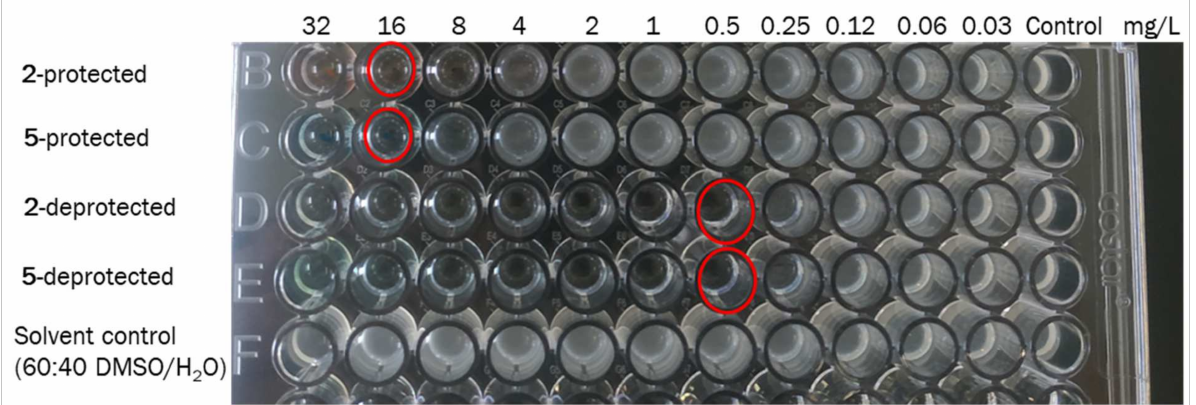
Figure 7. MIC study on E. coli ATCC 25922 of 2 and 5 . The wells corresponding to the minimum concentrations of compounds 2 and 5 in which no bacterial growth was detected (MIC values) are marked with a red circle. The protected compounds showed higher MIC values than the deprotected ones, indicating that the antibiotic regains its activity upon light irradiation. The solvent control did not affect bacterial growth. Green light (100 W, 520 nm for compound 2 ) or red light (50 W, 625 nm for compound 5 ) were used for 1